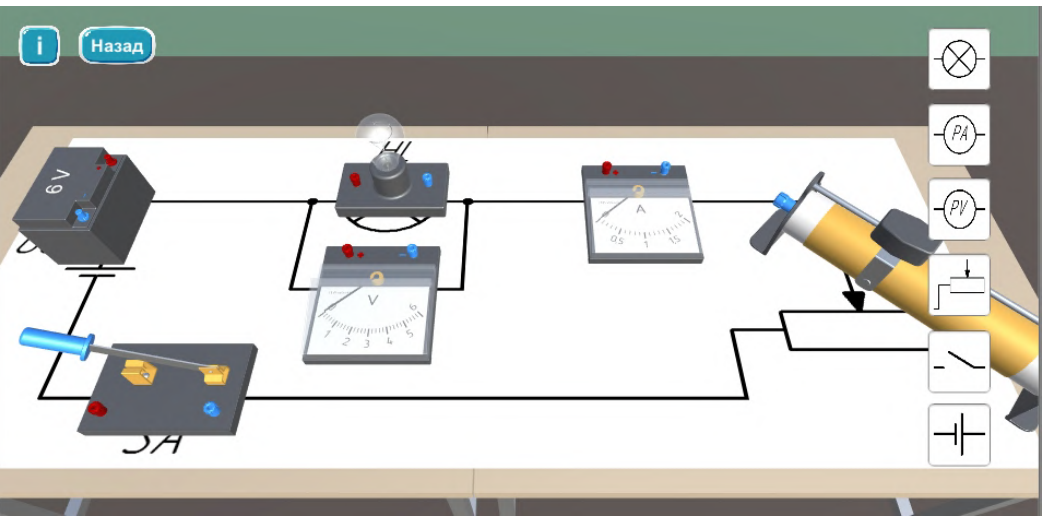
Figure 11: Successful theory checks